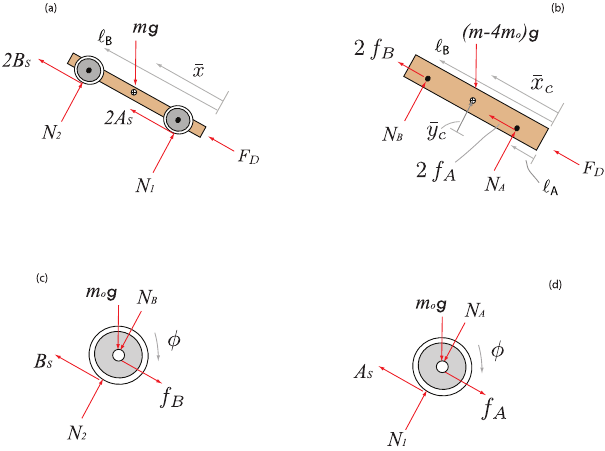
Figure 3. Free body diagram of the forces on (a) the assembled car, (b) only the car body, (c) the rear wheel, and (d) the front wheel.